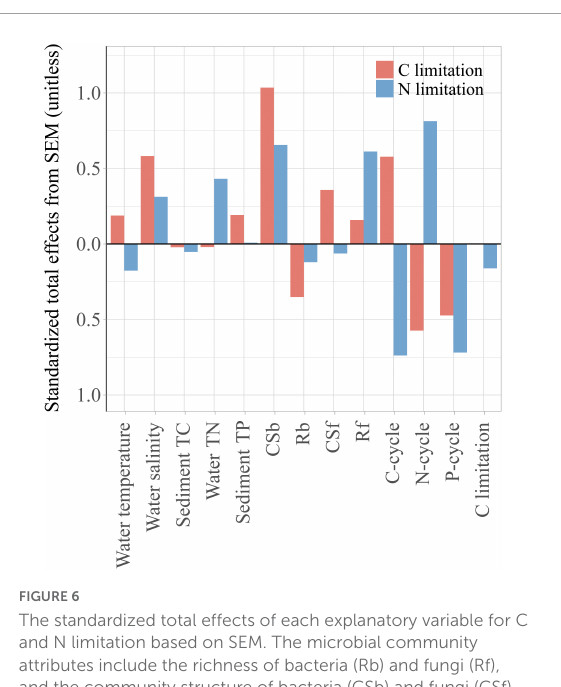
FIGURE6 The standardized total effects of each explanatory variable for C and N limitation based on SEM. The microbial community attributes include the richness of bacteria (Rb) and fungi (Rf), and the community structure of bacteria (CSb) and fungi (CSf) represented by the first axis of detrended correspondence analysis of the